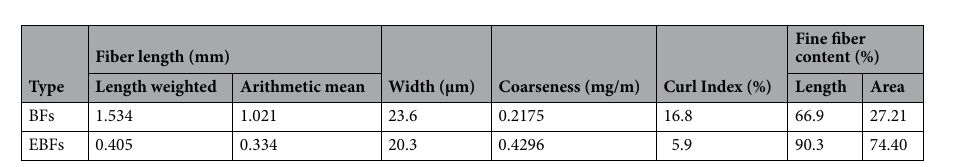
Table 1. Physical properties of BFs and EBFs.